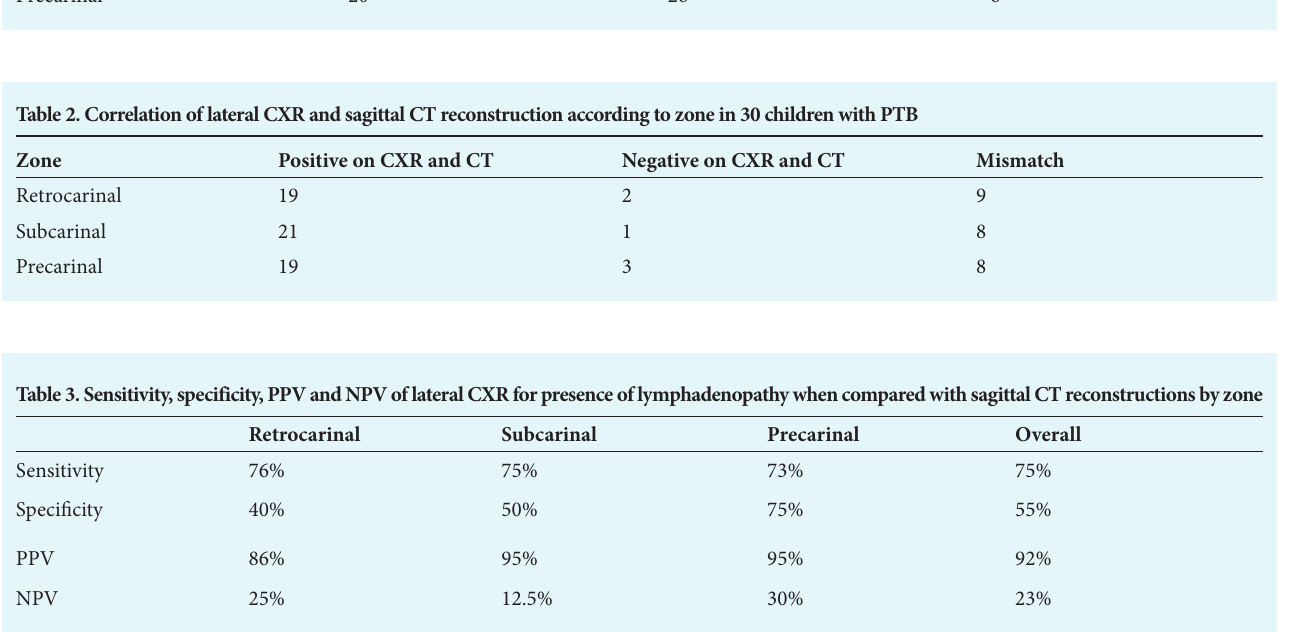
PPV = positive predictive value; NPV = negative predictive value.